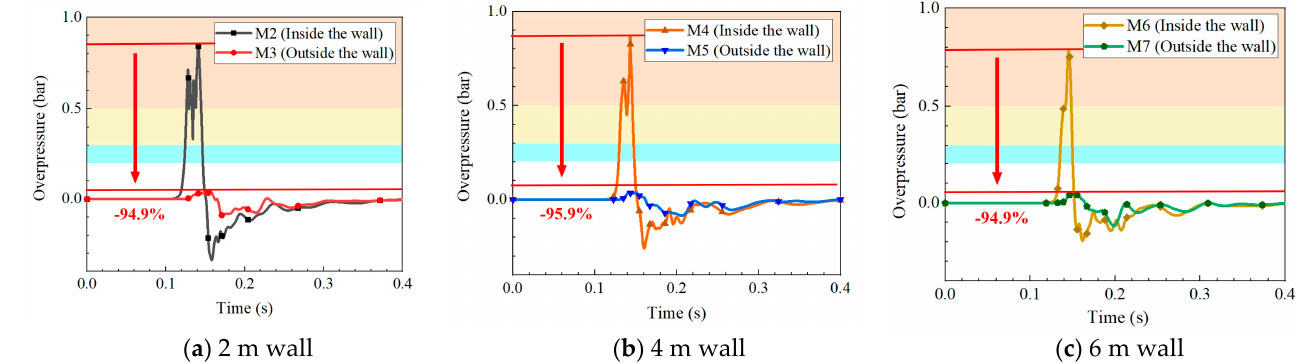
Figure 10. Evolution of the hydrogen overpressures in front of the SHRS for various protective wall distances.